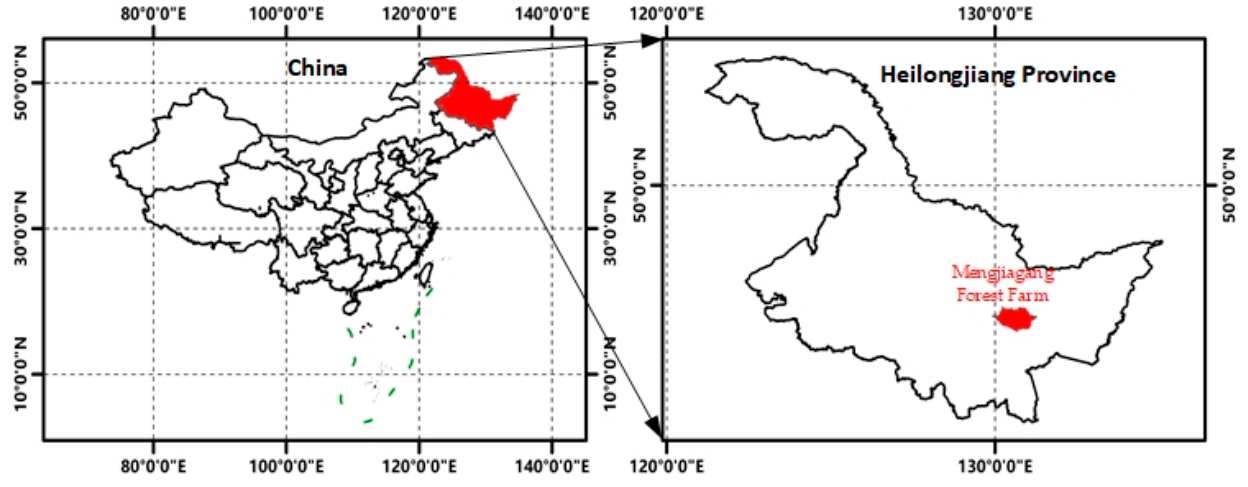
Figure 1. Map of the Mengjiagang forest farm in Heilongjiang province, northeast China, showing the location of the study area.